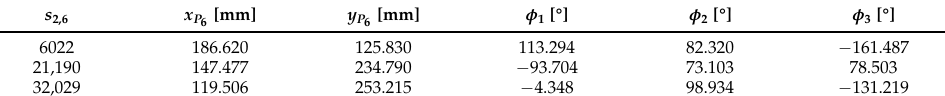
Table 8. The three real solutions of the DKP for the 5-RR prototype defined in Table 7 and the corresponding poses π .